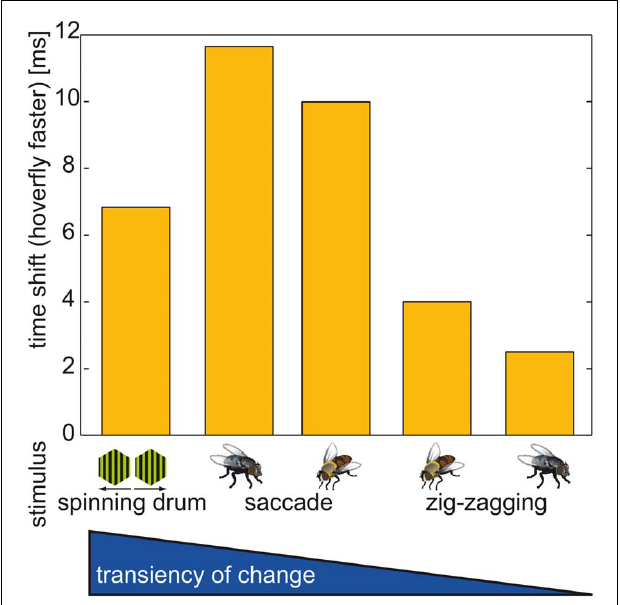
FIGURE 9 |Time shift overview. Time shift between the responses of Calliphora and Eristalis . In all cases Eristalis vCH reacted faster to the change in optic flow as determined by the time difference between reaching the half-maximal response. Below each bar the stimulus is depicted that corresponds to the time shift. Stimuli always built from changes to preferred direction motion.Time shifts corresponding to the following stimuli (from left to right): (1) Instantaneous direction inversion in a spinning drum experiment; (2) Calliphora saccade; (3) Eristalis saccade; (4) Switch from a forward-right to a forward-left movement in Eristalis ; (5) Switch from a forward-right to a forward-left movement in Calliphora ; Note that the sideways component preceding the switch is much smaller in Calliphora than in Eristalis , therefore the change in optic flow is larger in (4) than in